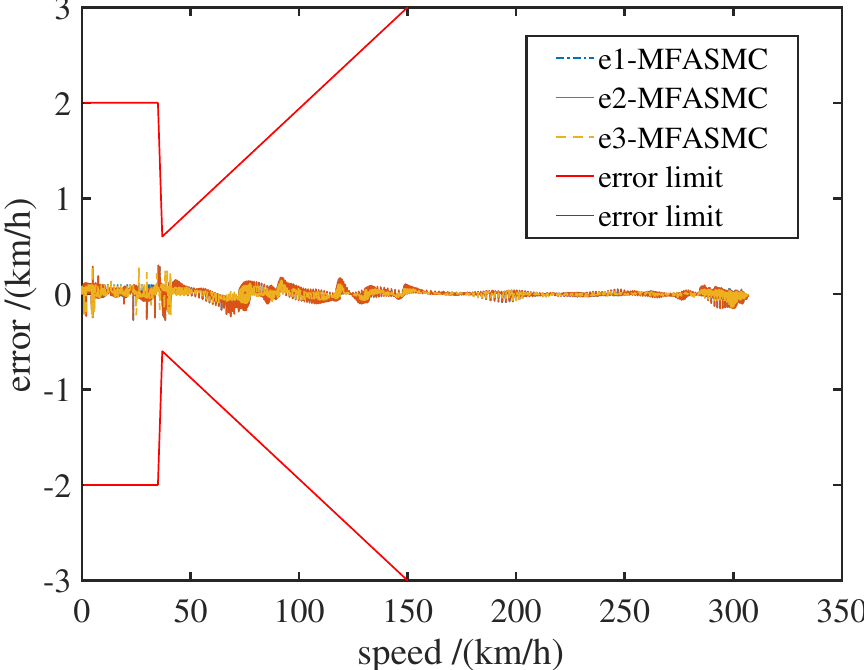
Figure 7. The speed level error curve of each power unit of